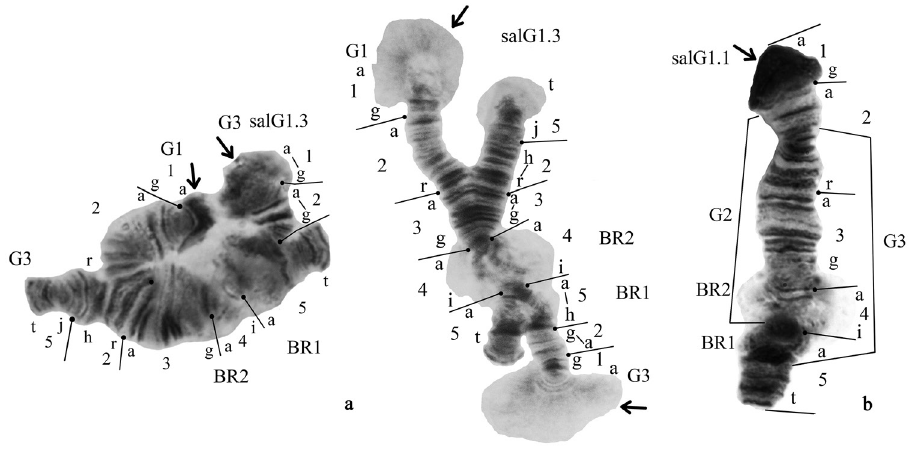
Figure 7. Banding sequences in the arm G of G. salinus . Key: a two different photo of heterozygote salG1.3 and b homozygote salG1.1. Designations as in Fig.